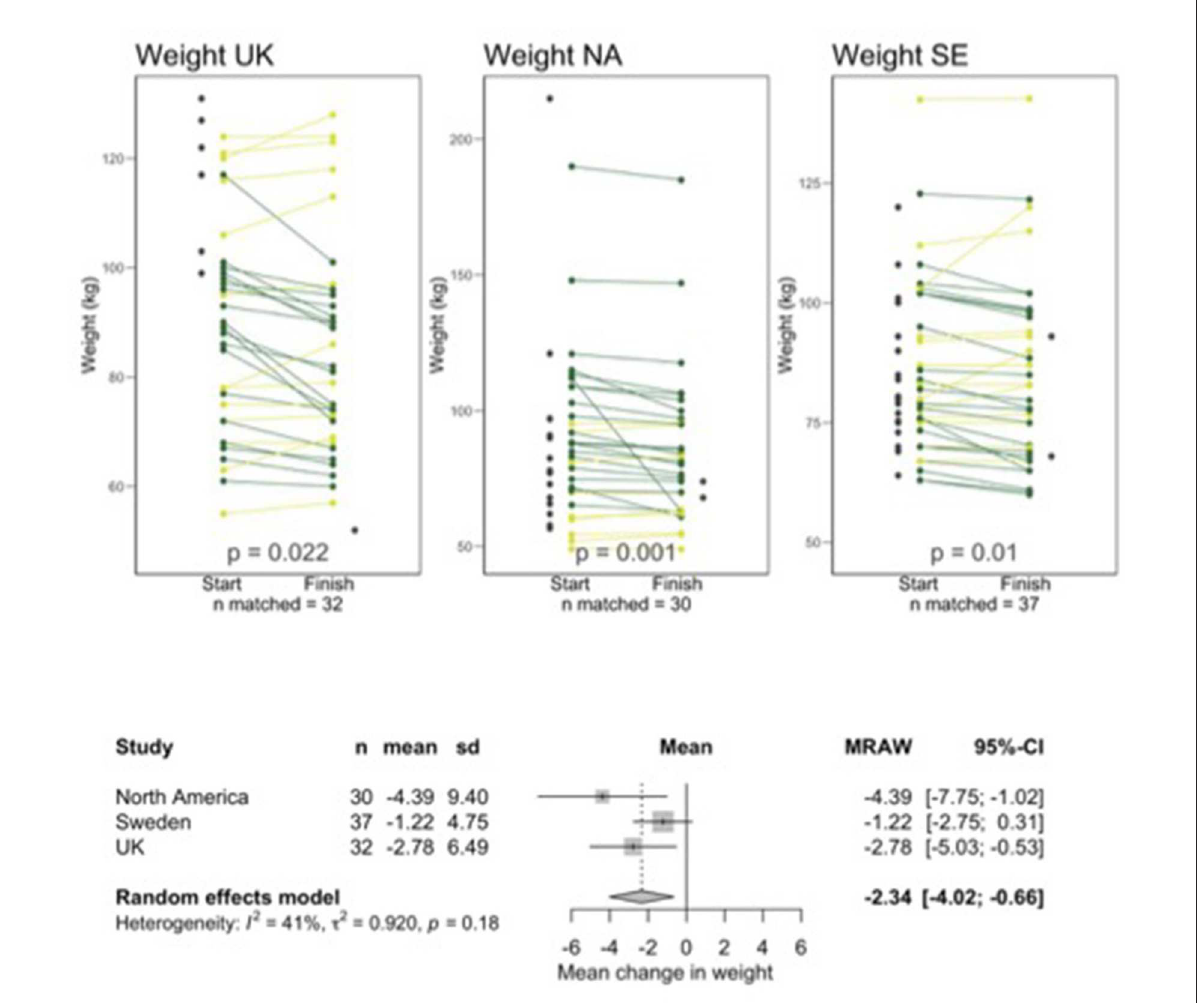
FIGURE4 Line and forest plots for weight. Dark green indicates improved scores, light green indicates worsening score or no change. Dark gray data points without a line represent people who started but did not finish or who completed a follow up questionnaire but could not be matched with a starting